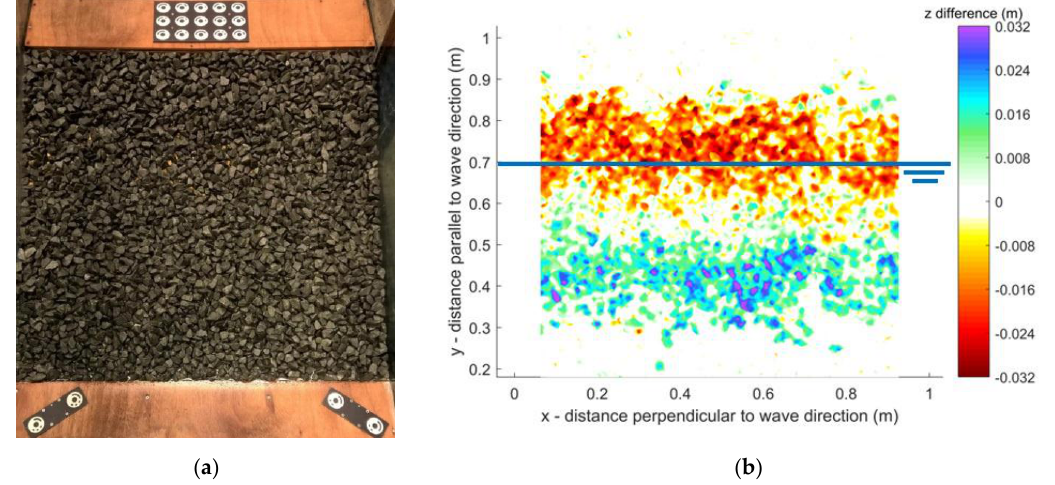
Figure 4. Image of the rock armoured slope ( a ) and an example of the measurement (compared to the initial situation) of the distribution of damage using digital stereo photography (DSP), where the warm colours denote erosion and the cold colours denote accretion ( b ).